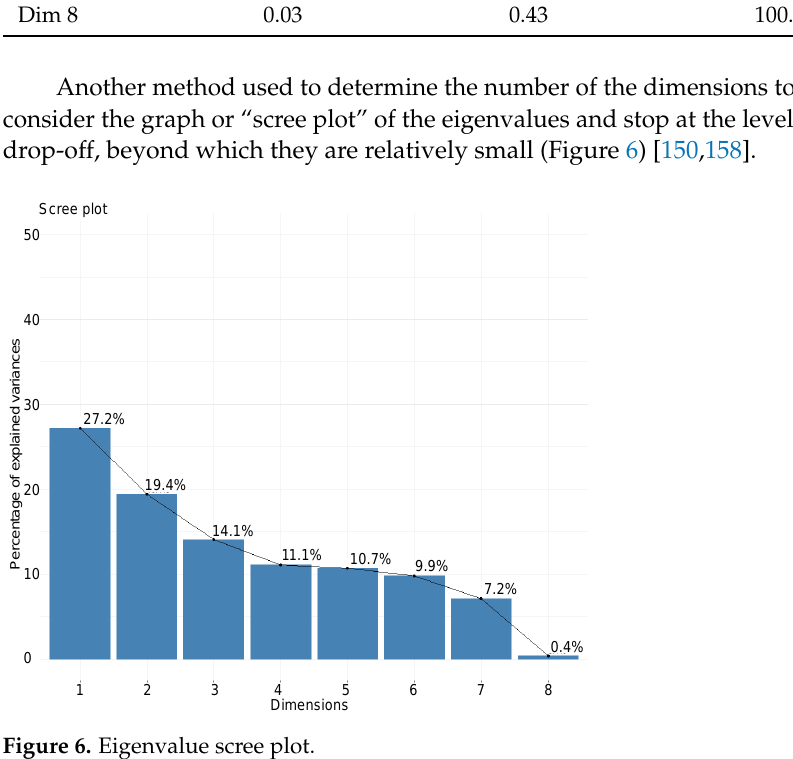
Figure 6. Eigenvalue scree